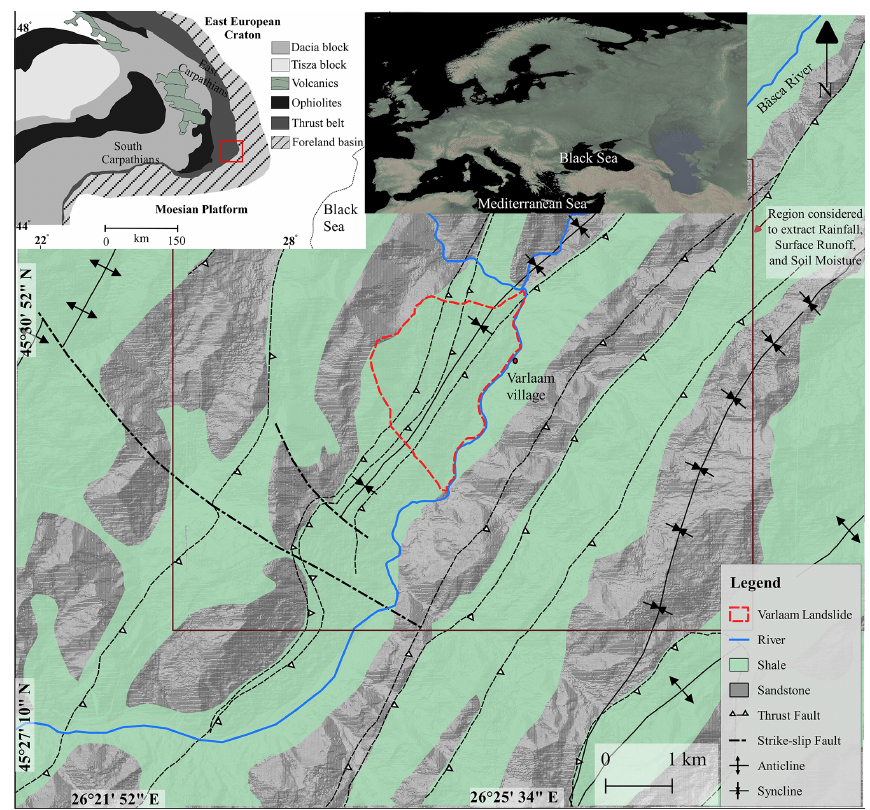
Figure 1. Study area. Inset (a) (source: NOAA NCEI, USA) and (b) (after Ustaszewski et al., 2008) highlight the position of the study area. Geological setting is based on Murgeanu et al. (1965), Tischler et al. (2008), and Pospíšil et al.